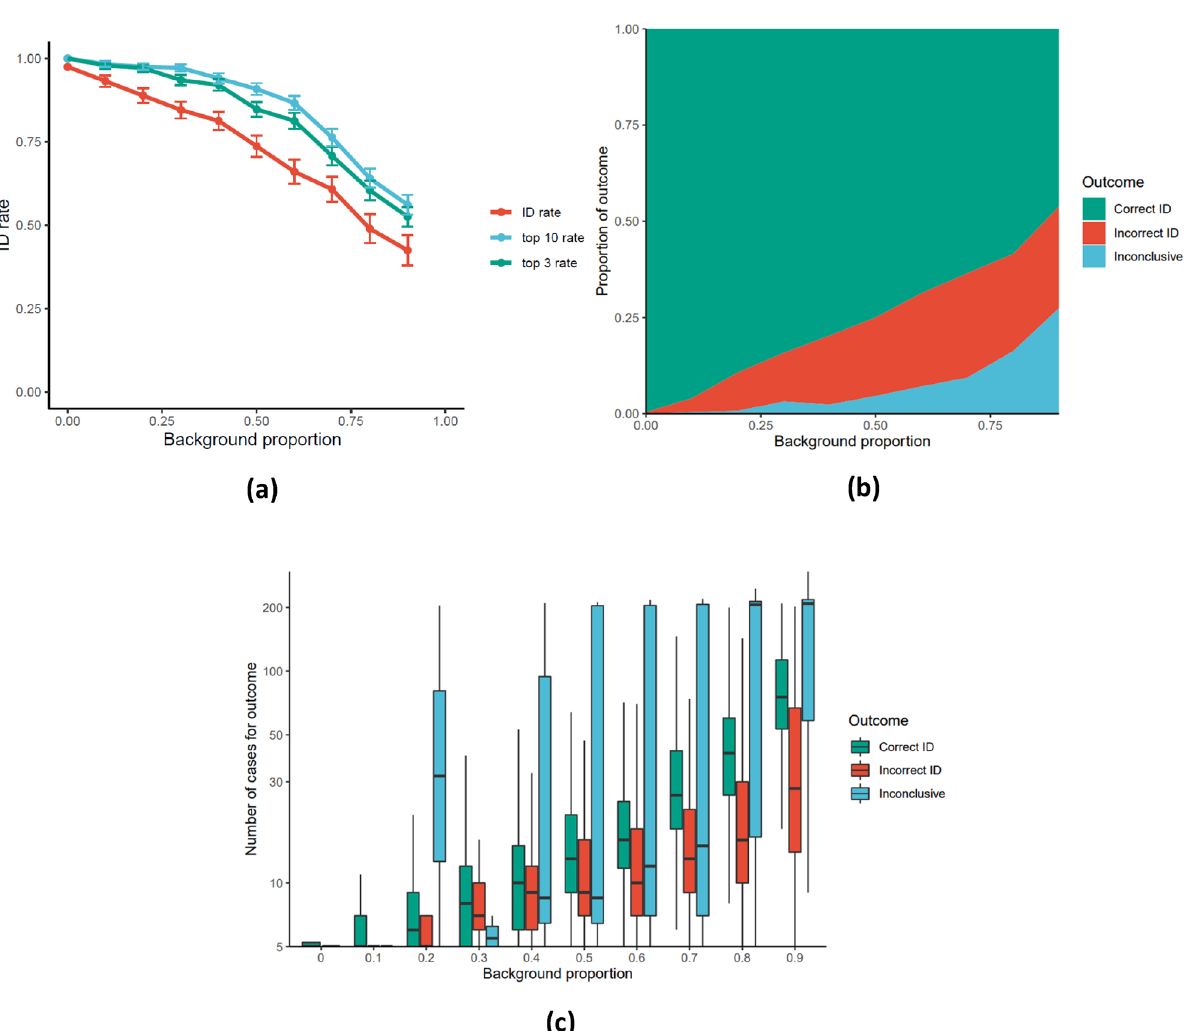
Figure 4. Effect of background case proportion (in range 0–0.9) on analysis of 300 simulated outbreaks with respect to ( a ) average correct identification (ID) rate top 3 rate, and top 10 rate with standard errors. ( b ) Proportional composition of each possible analysis outcome, and ( c ) boxplot of the number of cases analyzed by the model before returning the labeled outcomes. The upper and lower boundaries of the boxes indicate the group 75th (Q3) and 25th (Q1) percentile respectively, the black line within the boxes marks the group median, and whiskers extend to the least extreme data point within ± 1.5 *Interquartile range (Q3–Q1). Y-axis on log scale. Outbreak analysis was initialized at 5 cases and terminated if the number of cases exceeds 200 due to computational